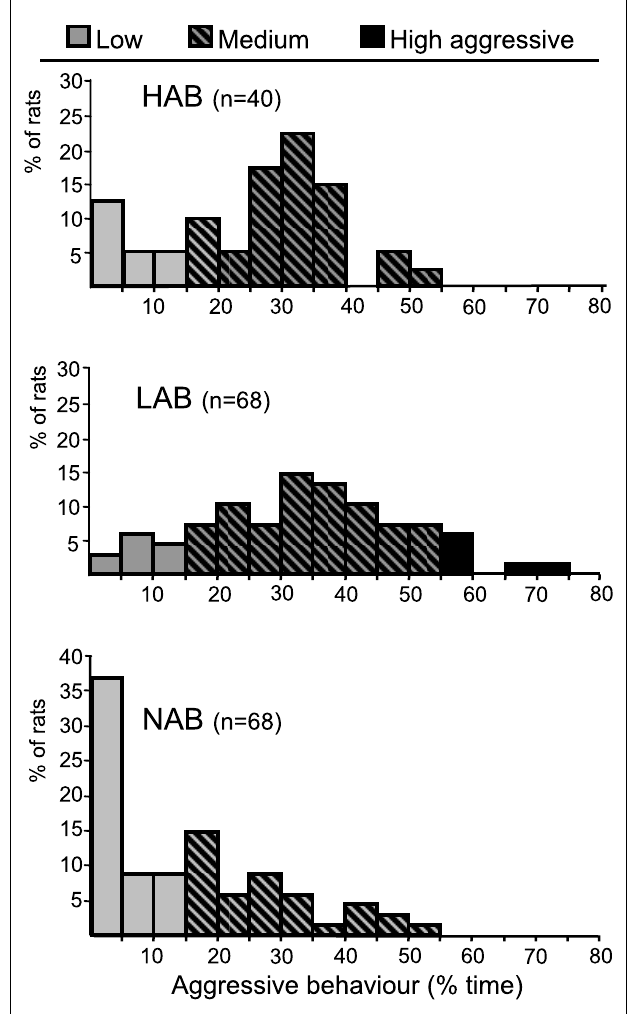
FIGURE 4 | Allocation of HAB, LAB, and NAB male in low-, medium- and high-aggressive. Rats are categorized according to their level of aggressive behaviour expressed as percentage of time in the RI test (low-aggressive: less than 15% aggressive behaviour; medium-aggressive: between 15 and 55% aggressive behaviour; high-aggressive: more than 55% aggressive